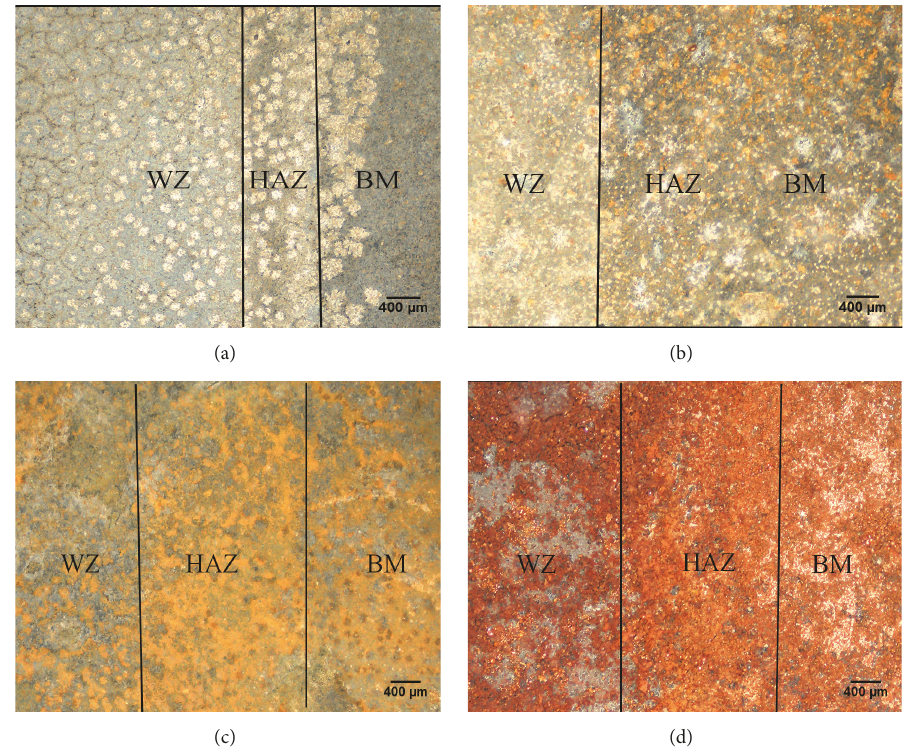
Figure 8: The macroscopic appearance of different corrosion